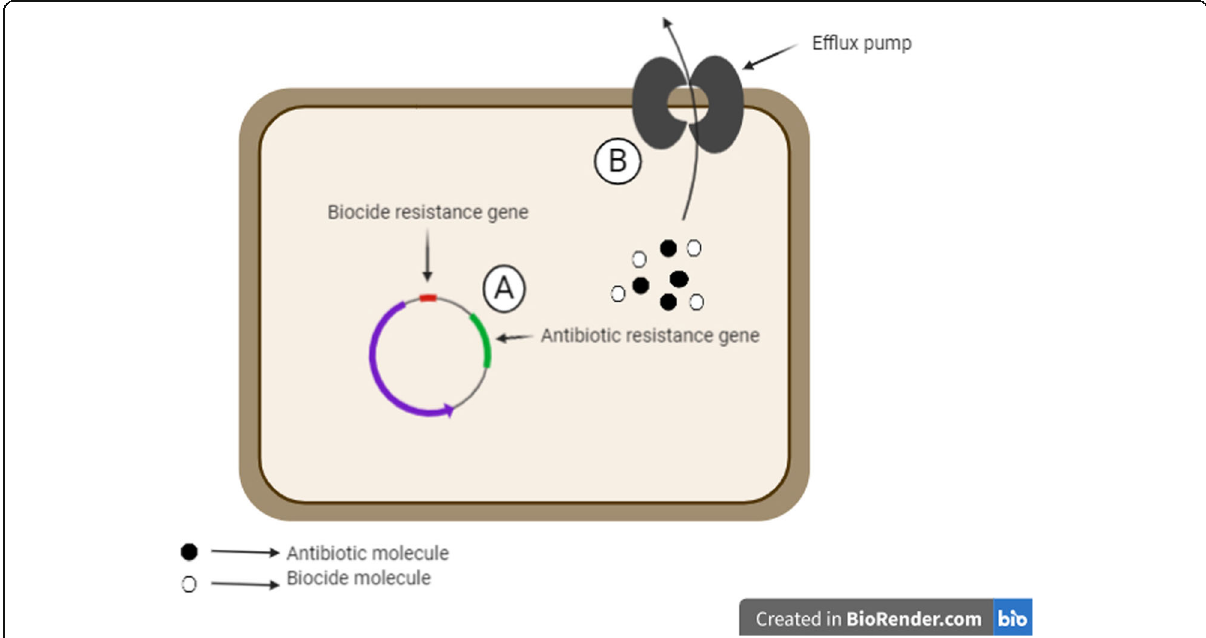
Fig. 2 Co-selection in bacteria. A: Co-resistance where the genes of resistance to antibiotics and biocides are physically located on the same mobile genetic element. B: Cross-resistance where a single gene encoding a resistance mechanism (e.g., efflux pumps) confer resistance to both biocides and